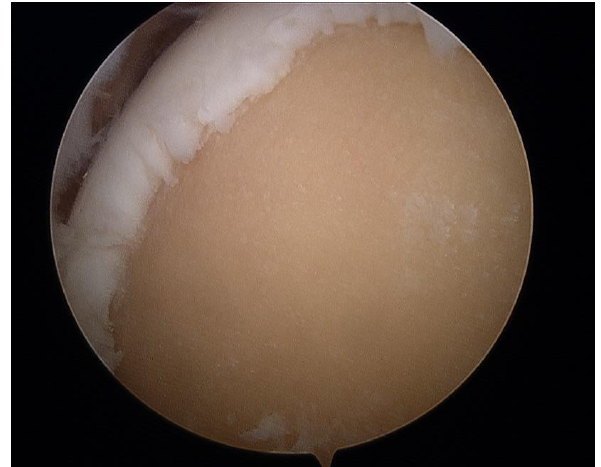
Figure 1. Preparation of microfracturation zone.